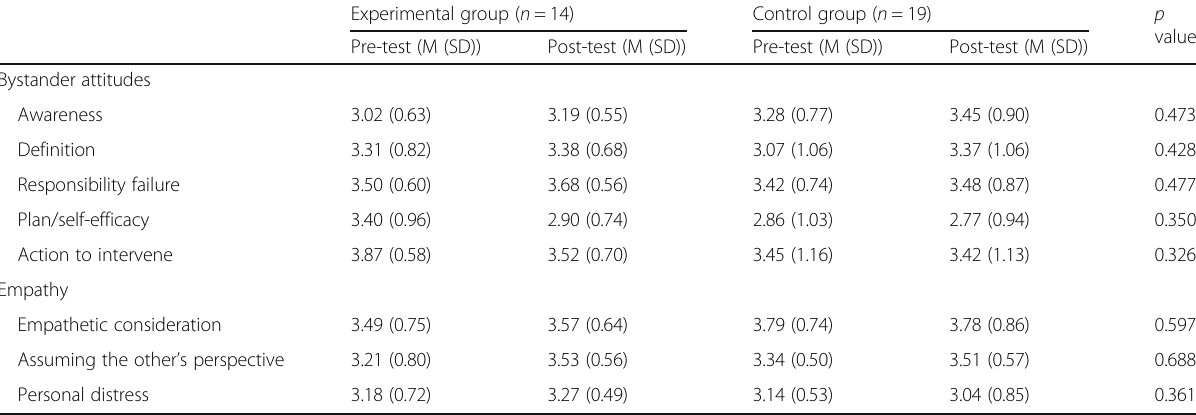
Table 5 ESPECTA-VN and empathy scales before and after the intervention by experimental